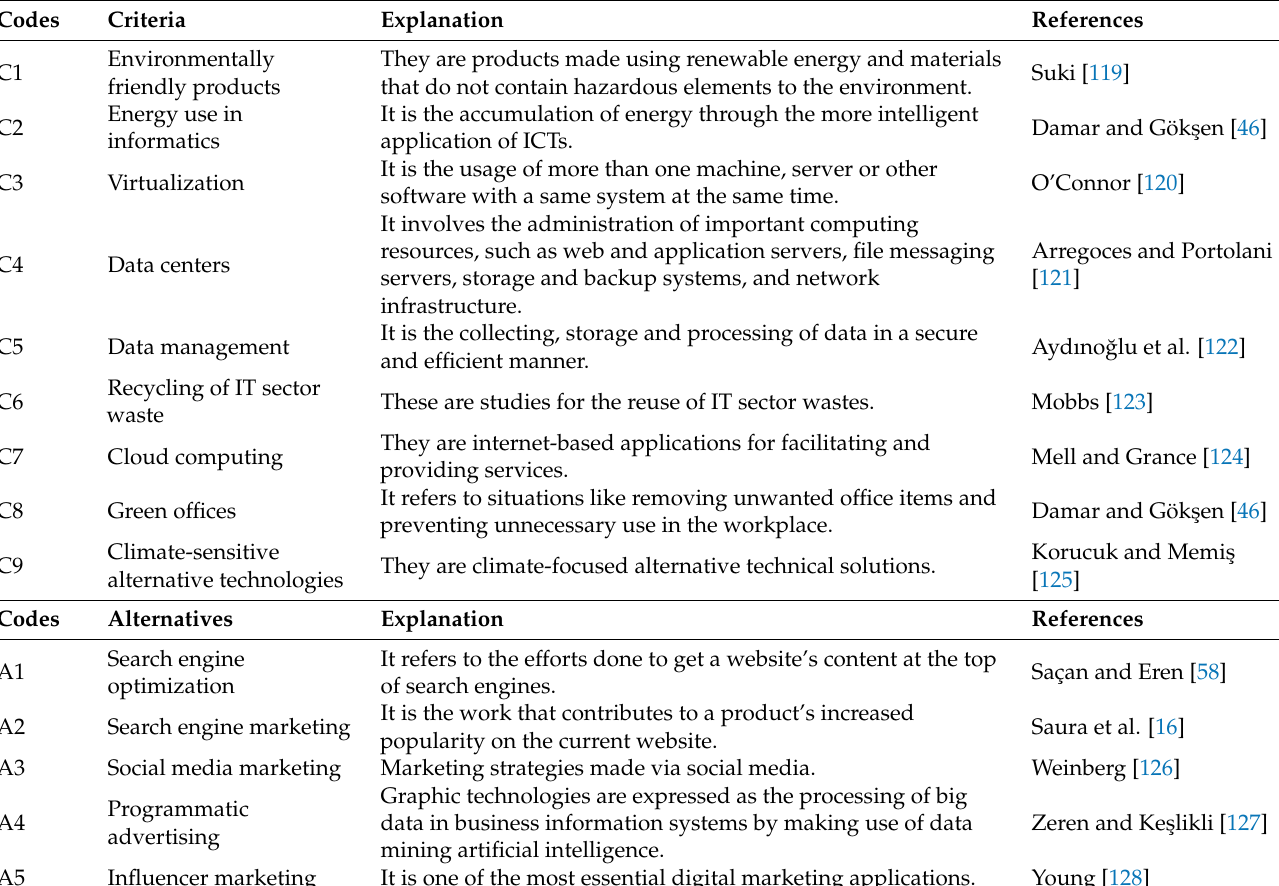
Table 7. The criteria and alternatives for evaluating the green approaches and digital marketing strategies.